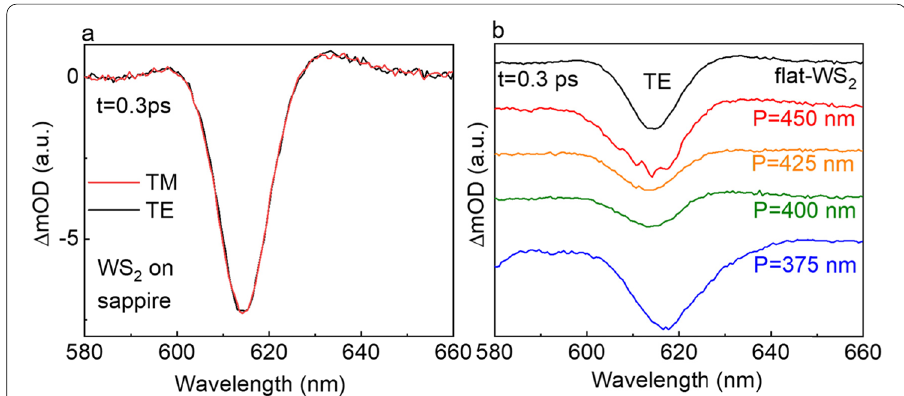
Fig. 2 a Linear polarized TA spectra of monolayer WS 2 in TM and TE mode at 0.3 ps. b Linear polarized TA spectra of monolayer WS